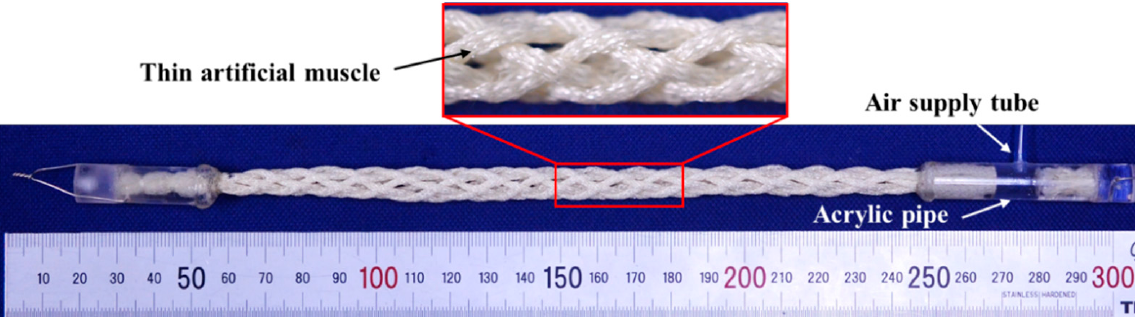
Figure 2. Appearance and structure of the active string actuator.